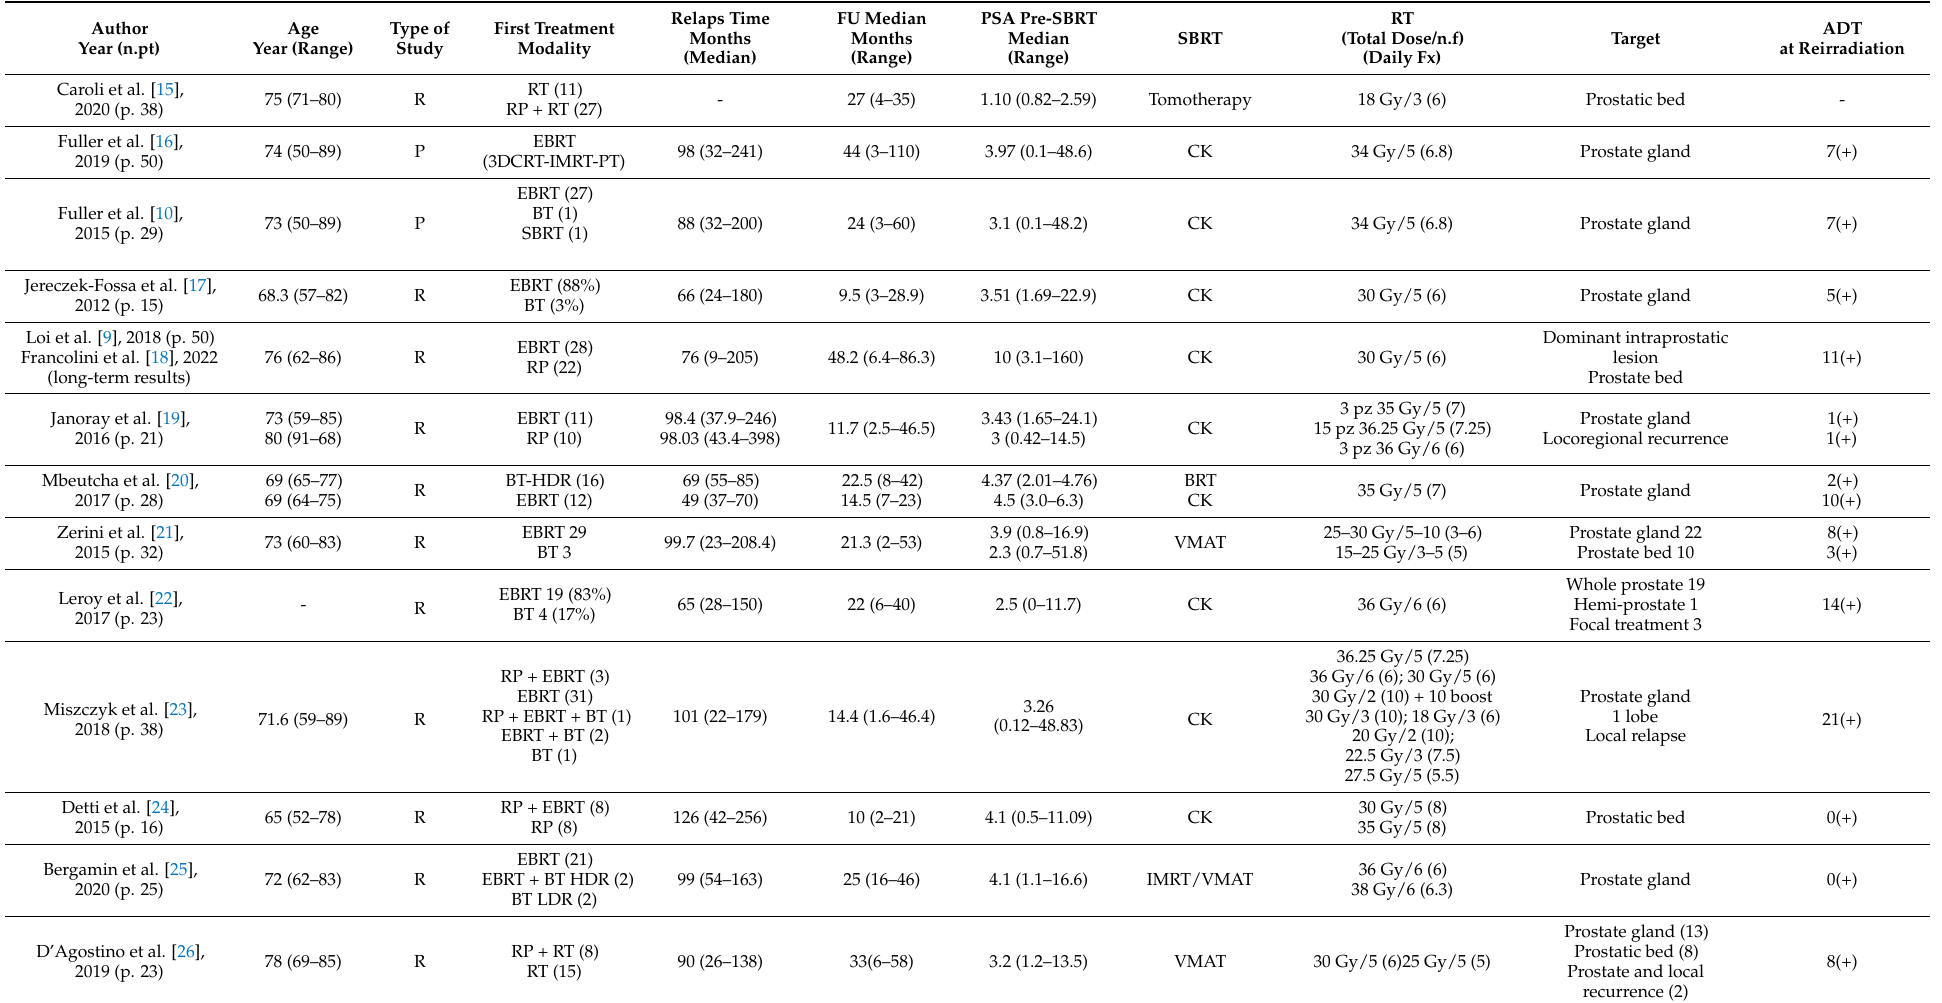
Table 6. Literature search: type of radiotherapy, dose, fractionation, follow-up, target, and androgenic deprivation